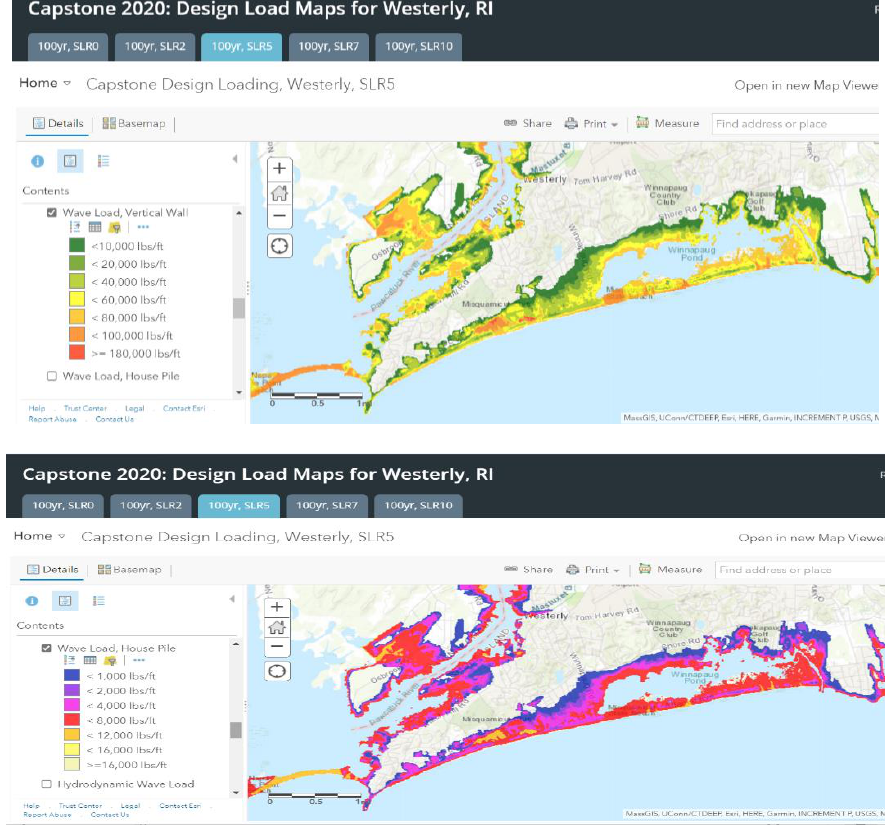
Figure 9. Wave load (lbs/ft) for vertical wall ( upper panel) and pile ( lower panel) house, 100 yr storm, 5 ft sea level rise (SLR).